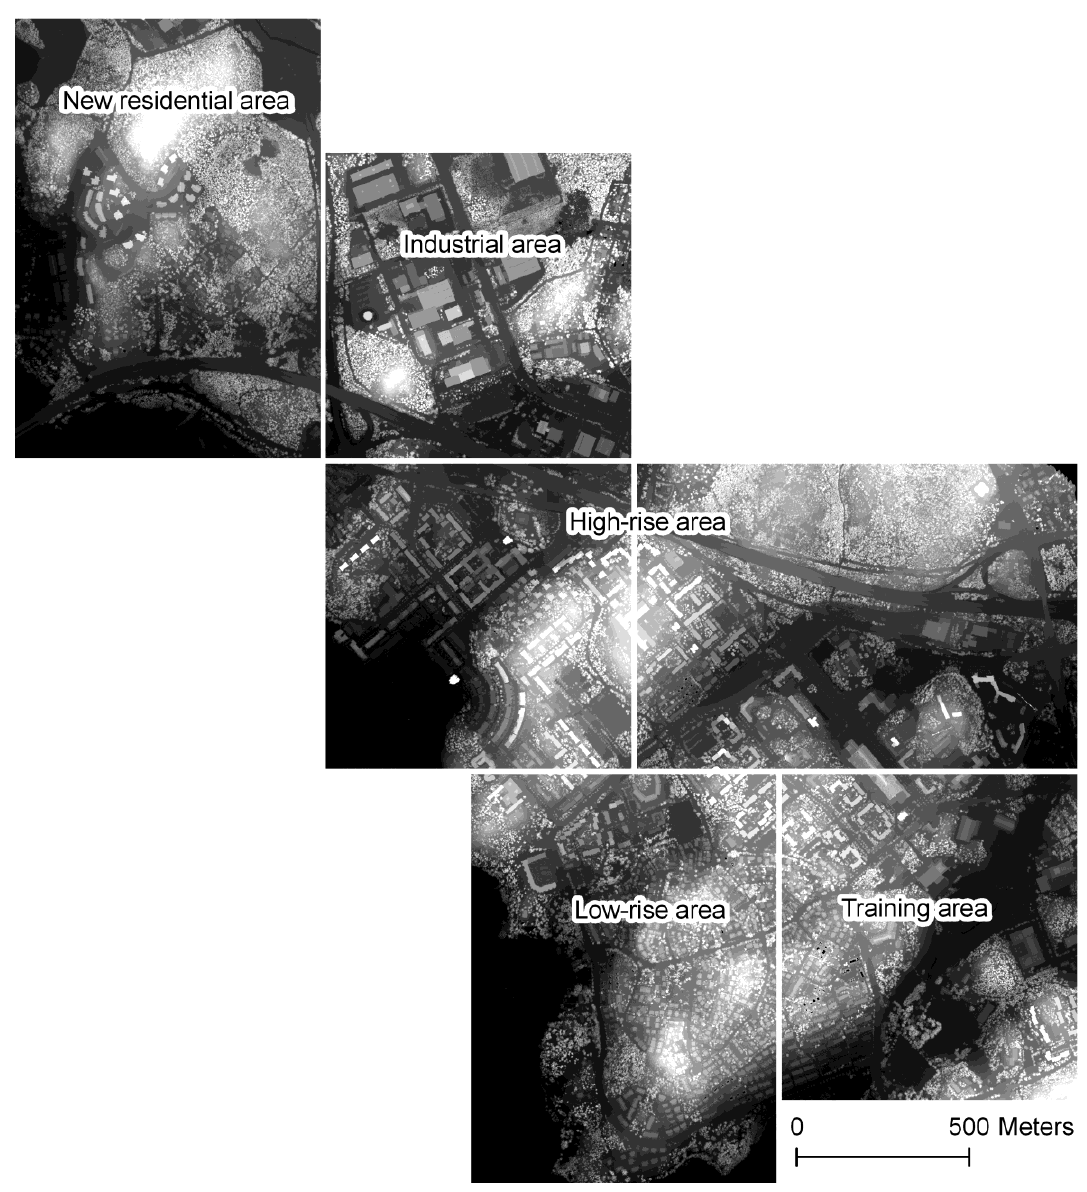
Figure 1. Minimum DSM from different subareas of the study area. The training area was used for creating classification rules and the other areas were used for testing the